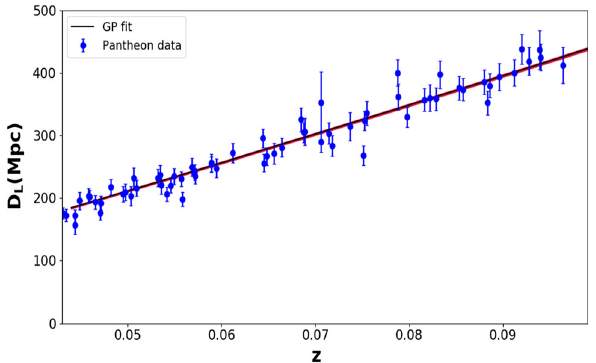
Fig. 4 The distribution of C with mean value of C = 0 . 93 ± 0 . 16. For this plot we have assumed M B = − 19 . 253 ± 0 . 027